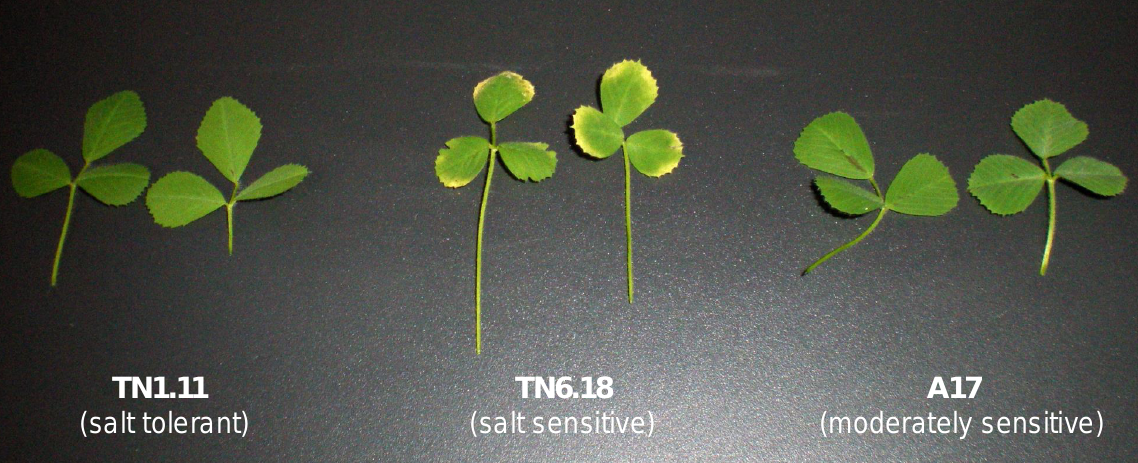
Figure 1. Representative image of mature leaves of TN1.11 (salt-tolerant), TN6.18 (salt-sensitive), and Jemalong A17 (moderately salt-sensitive) genotypes after 48 h 200 mM NaCl.